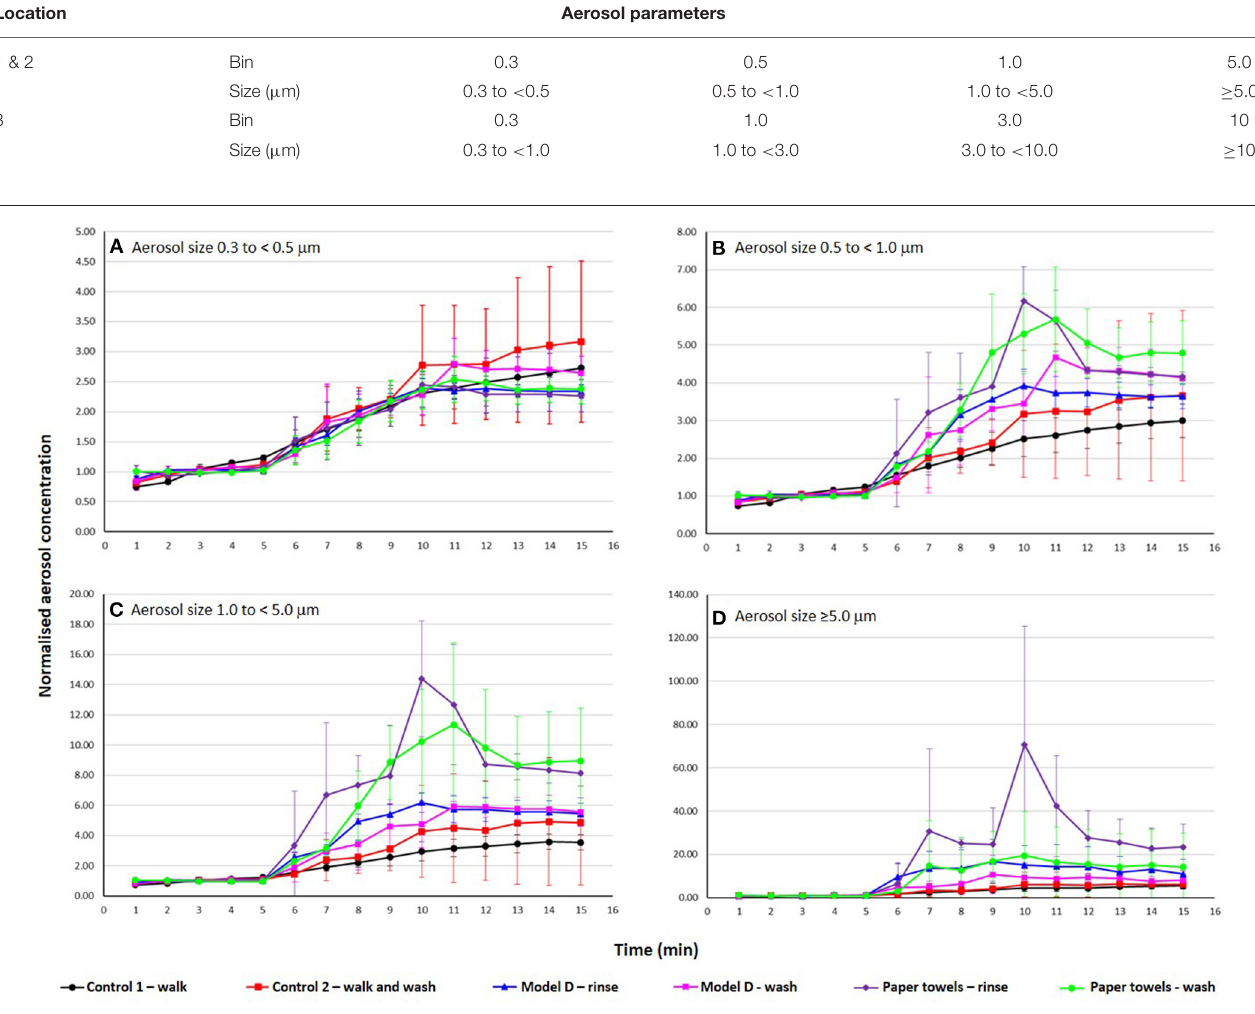
FIGURE 3 | Normalized concentrations for model D for aerosol bins (A) 0.3, (B) 0.5, (C) 1.0, and (D) 5.0 for location 2 (near the hand dryer). Each curve represents ( ) control experiment 1 (walking only), ( ) control experiment 2 (walking and hand washing), and drying hands with jet air dryer model D after ( ) rinsing and (